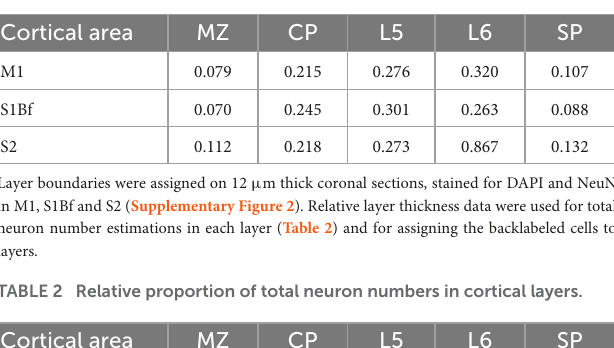
TABLE 1 Relative thickness of cortical